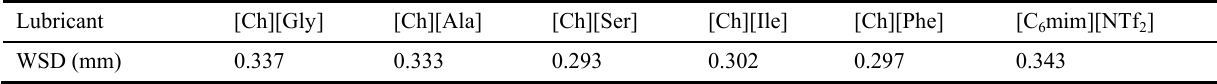
Table 2 Ball wear diameter after the SRV test for different